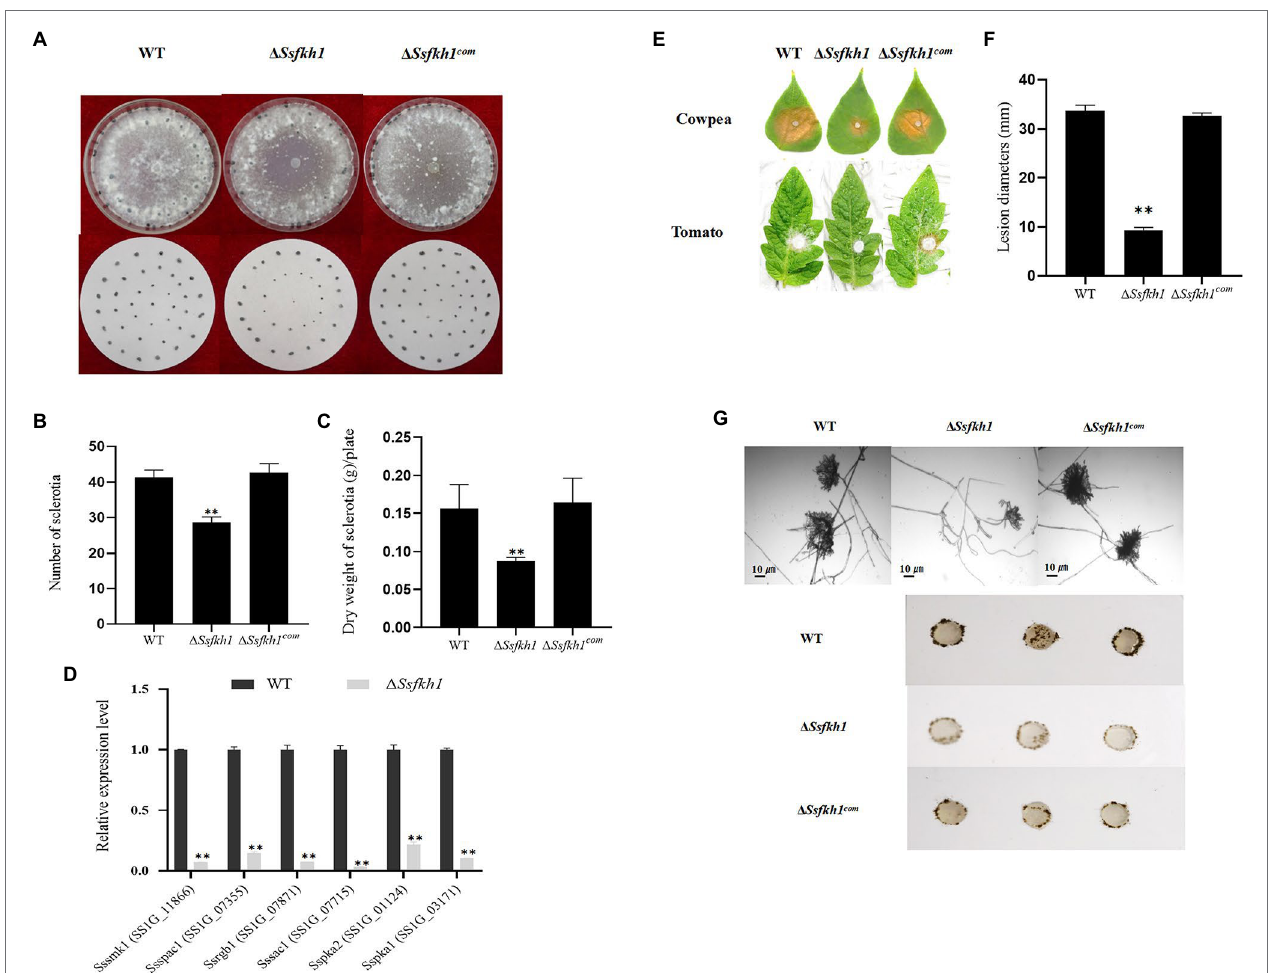
FIGURE 1 | (A) Morphologic observation of the WT, Δ Ssfkh1 , and Δ Ssfkh1 com strains on potato dextrose agar (PDA) medium. Photographs were taken by 14 DAI. (B) Comparison of sclerotium numbers among WT, Δ Ssfkh1 , and Δ Ssfkh1 com . Sclerotia were collected from 9-cm-diameter SPA plates for statistics analysis. Number of sclerotia in WT, Δ Ssfkh1 , and Δ Ssfkh1 com strains. (C) Comparison of sclerotium dry weights among WT, Δ Ssfkh1 , and Δ Ssfkh1 com . Sclerotia were collected from 9-cm-diameter SPA plates for statistics analysis. Number of sclerotia in WT, Δ Ssfkh1 , and Δ Ssfkh1 com strains. (D) Expression profiles of sclerotium- associated genes in SsFkh1 deletion mutants. Relative expression levels of sclerotium development-associated genes were investigated in hyphal tissue in Δ Ssfkh1 mutant and WT strains. The experiments were performed in triplicate [** p < 0.01 (Student’s t -test)]. Values are means ± SE. (E) Pathogenicity phenotype of WT, Δ Ssfkh1 , and Δ Ssfkh1 com strains on cowpea and tomato leaves. Pictures were taken by 2 DAI when the lesions were observed under the agar plug. (F) Lesion diameters were measured on tomato leaves daily until 3 DAI. Values on the bars followed by the same letter are not significantly different at p = 0.05. The experiment was repeated three times. (G) Compound appressoria of WT, Δ Ssfkh1 , and Δ Ssfkh1 com strains on glass sides were observed by light microscopy at 1 DAI and compound appressorium development of WT, Δ Ssfkh1 , and Δ Ssfkh1 com strains on glass sides at 3 DAI using 5 mm diameter mycelial